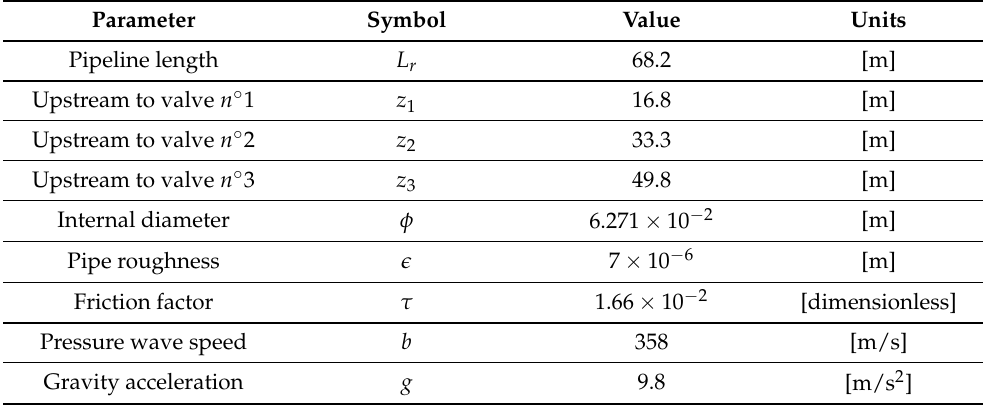
Table 1. Pipeline’s main